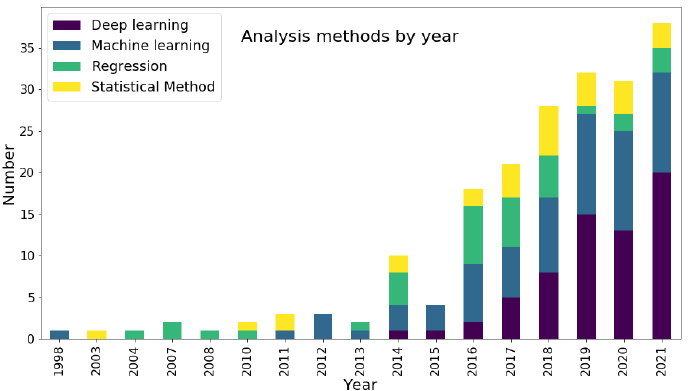
Figure 6. Distribution of predictive models used in the reviewed methods by publication